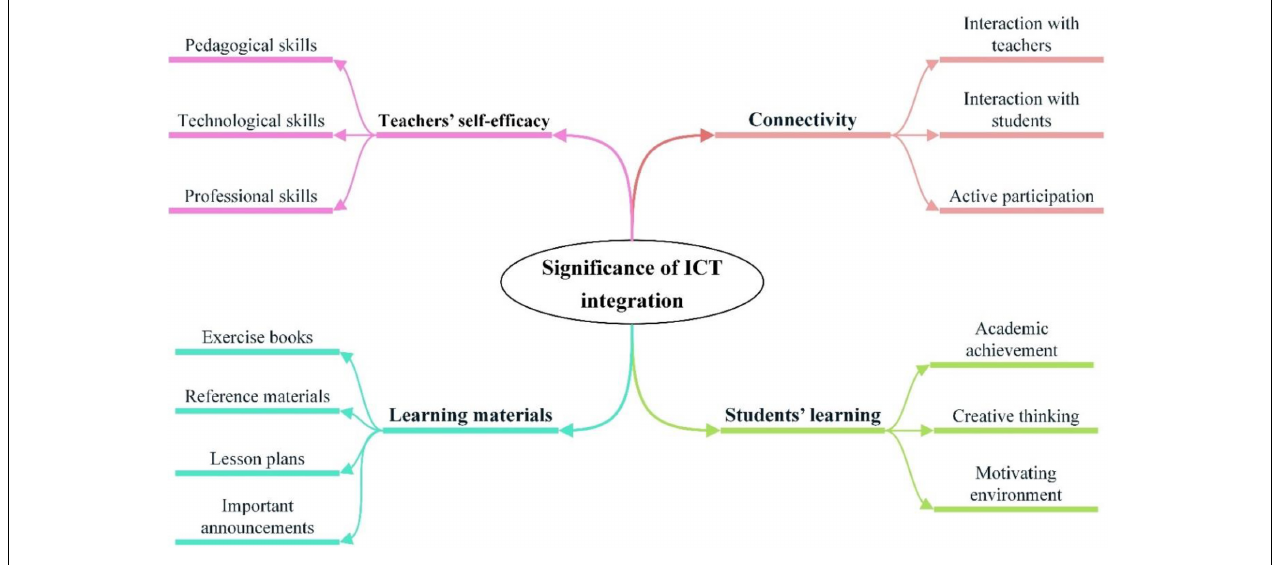
FIGURE 4 | Significance of information and communication technology (ICT)